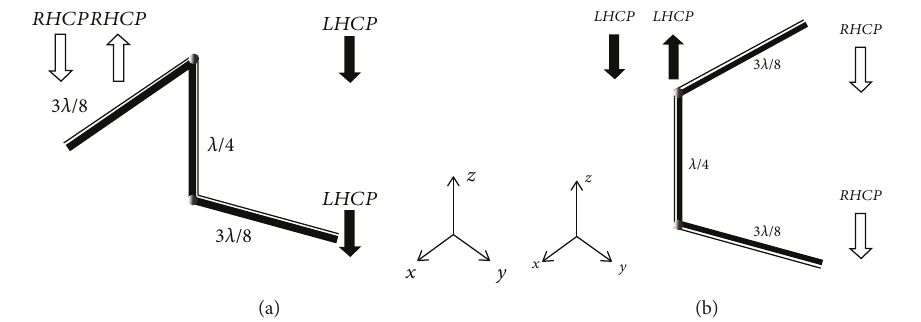
Figure 1: Pierrot cell con fi guration. (a) RHCPSS. (b) LHCPSS.